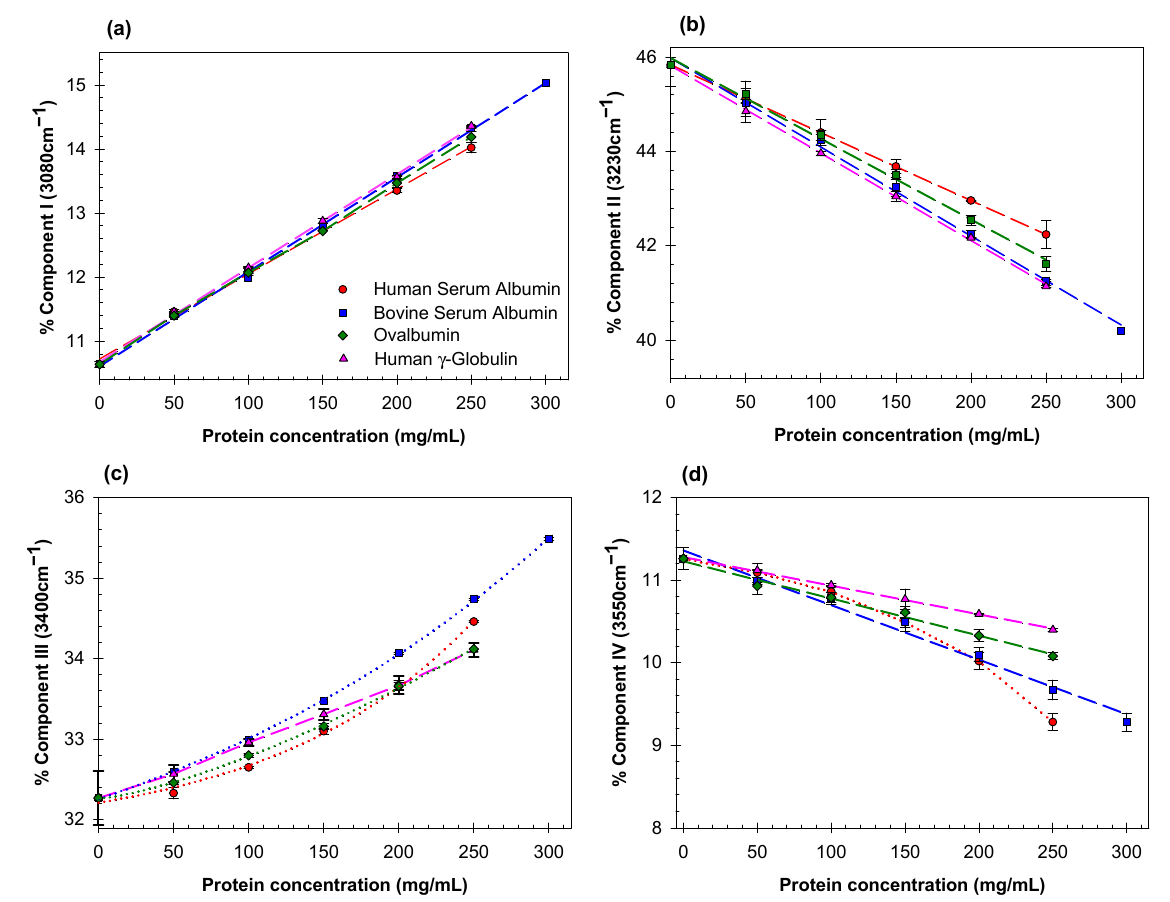
Figure 2. Concentration dependence of the relative contributions of the Gaussian components ( a ) I, ( b ) II, ( c ) III, and ( d ) IV for human serum albumin (red circles), bovine serum albumin (blue squares), ovalbumin (green diamonds), and human γ -globulin (magenta triangles).